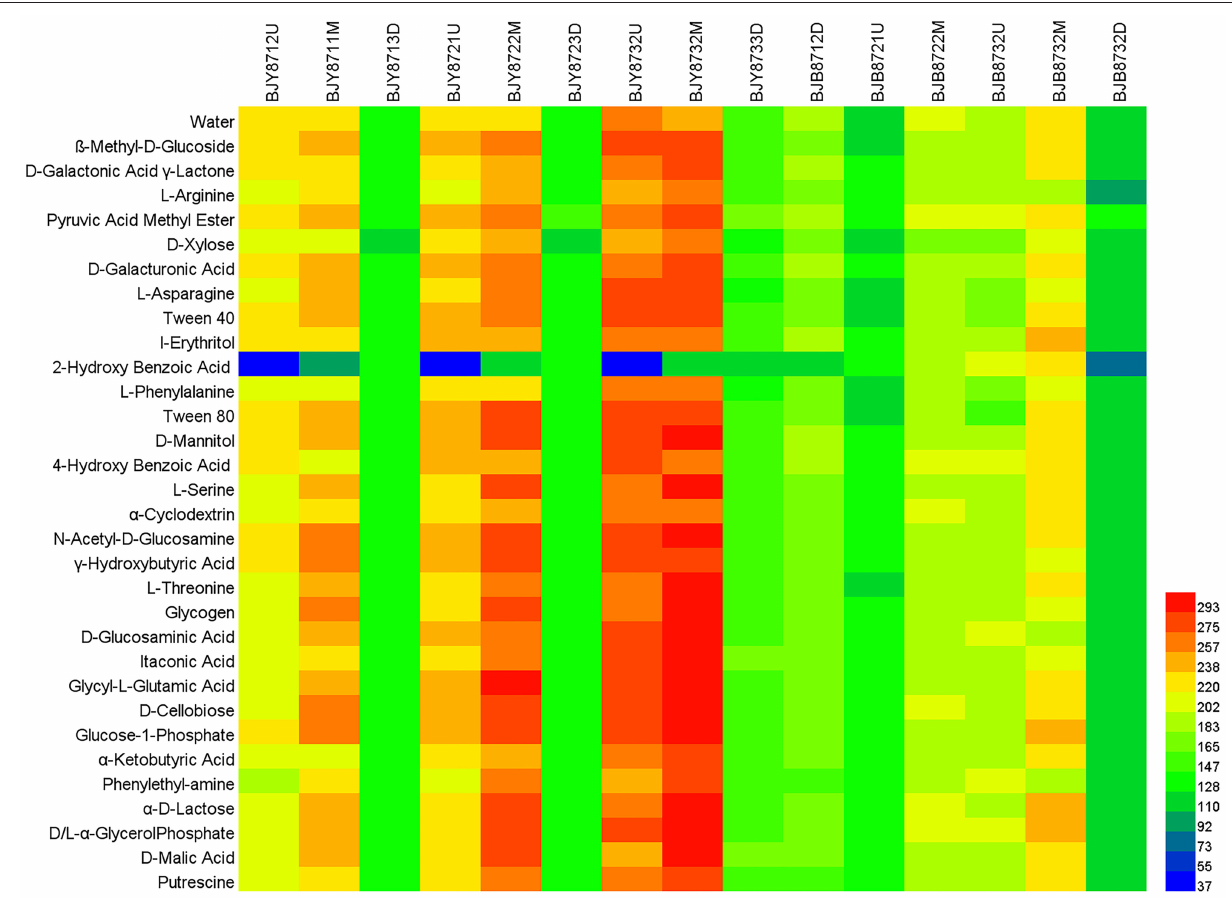
FIGURE 9 | Omnilog units (OUs) of carbon sources in BIOLOG ECO-Plate of microbial communities from different samples. The maximum OU values of 16 samples are